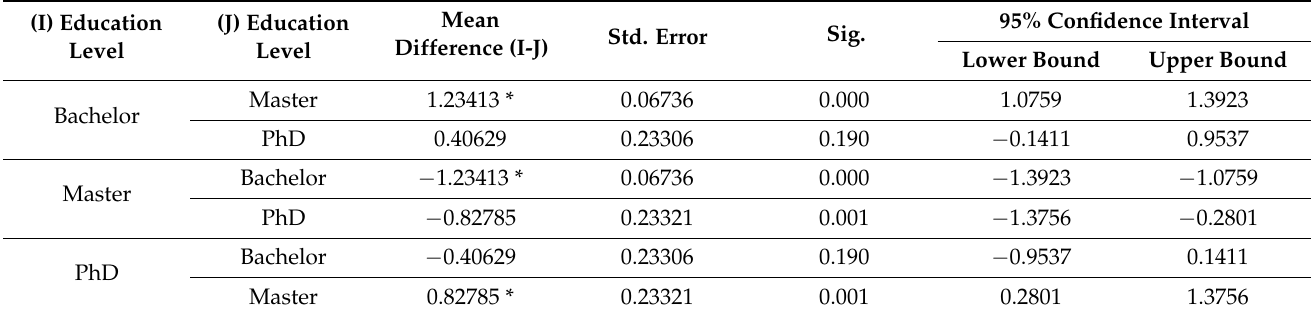
Table 11. Multiple comparisons analysis of the information adoption (IA) attributed to education.